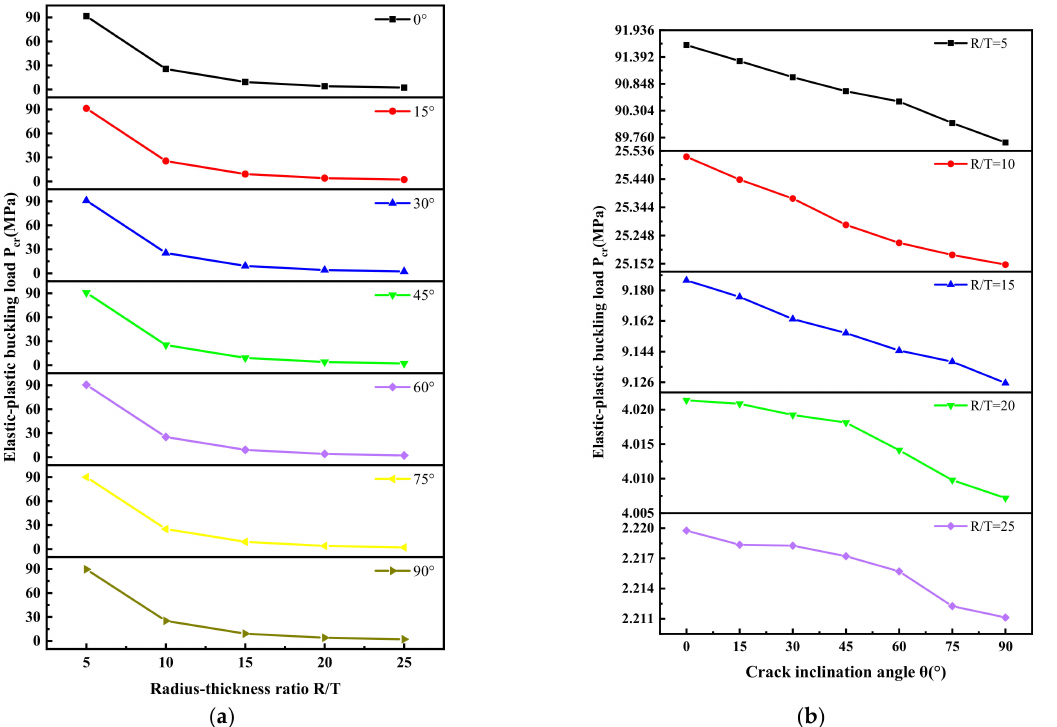
Figure 11. Relation between radius-thickness ratio and elastic-plastic buckling load ( a ) Different radius-thickness ratios; ( b ) Different crack inclination angles.